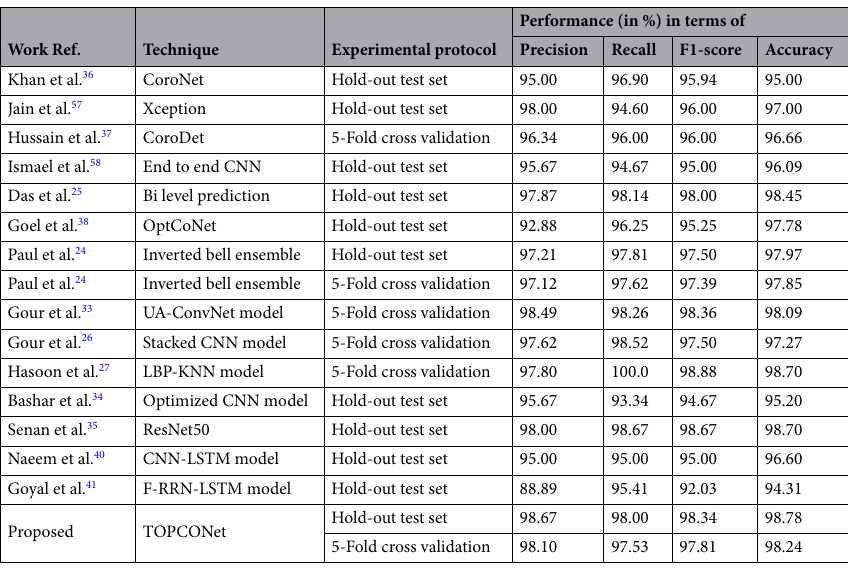
Table 7. Performance comparison of the proposed method with some state-of-the-art models on the Dataset-1.